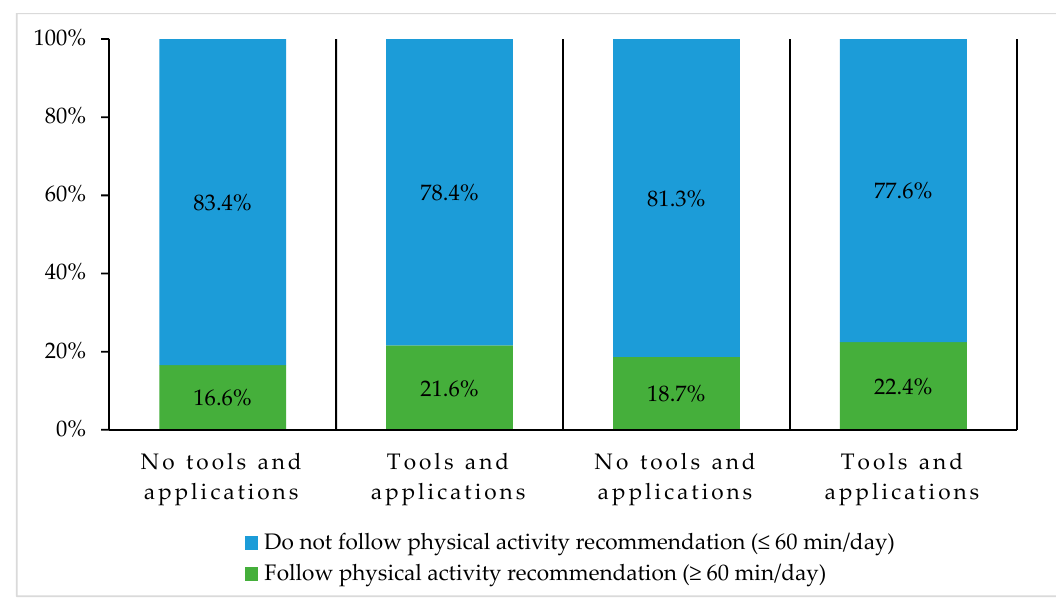
Figure 7. Association between the use of physical activity-related tools and applications, and the respect of the physical activity recommendation in adolescents. Pearson chi square p value < 0.05 for this association on both weekdays and weekend.